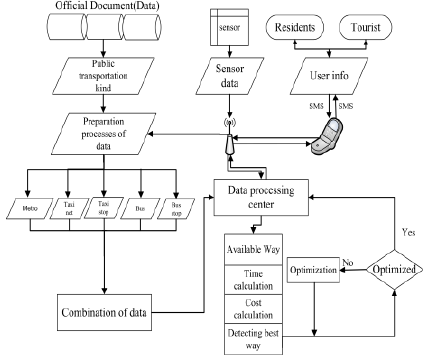
Figure. 7 Urban commuting time management in